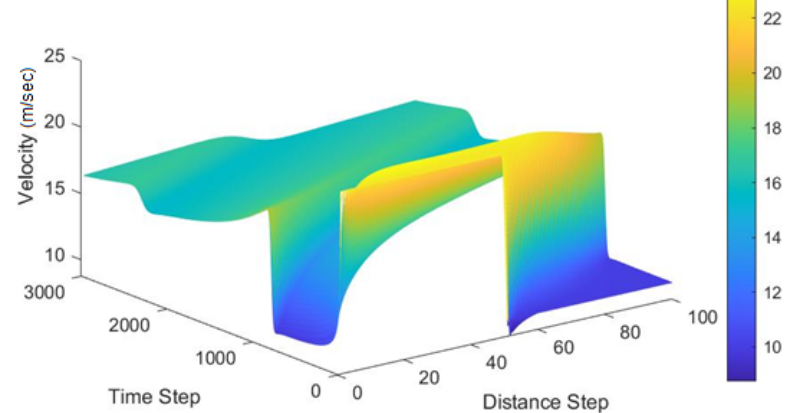
Figure 18. Density behavior of the proposed model on ring road.